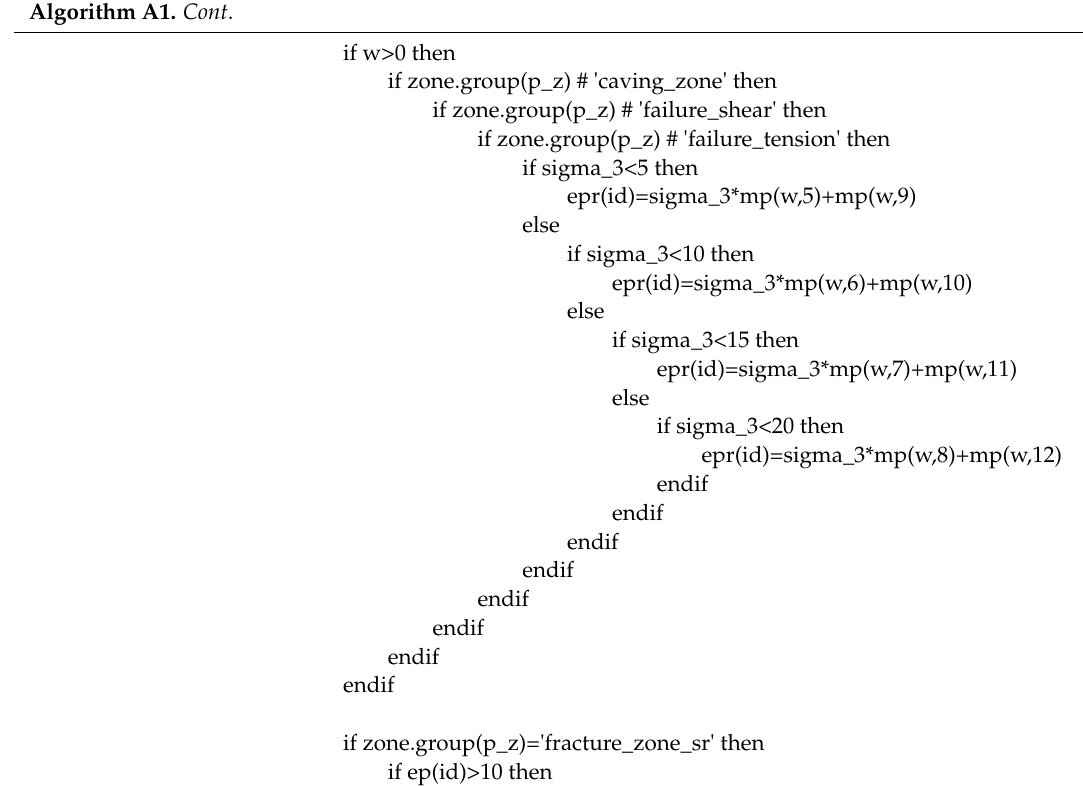
Algorithm A1. Cont